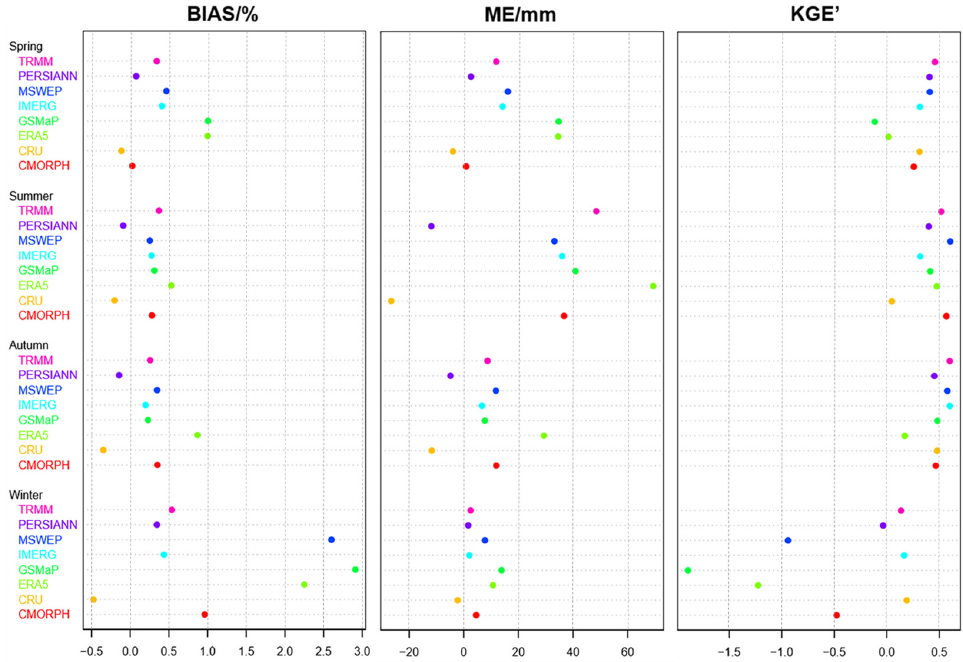
Figure 6. Dot plots of three indices of seasonal precipitation estimates from each product over the HRB during 2016–2019.